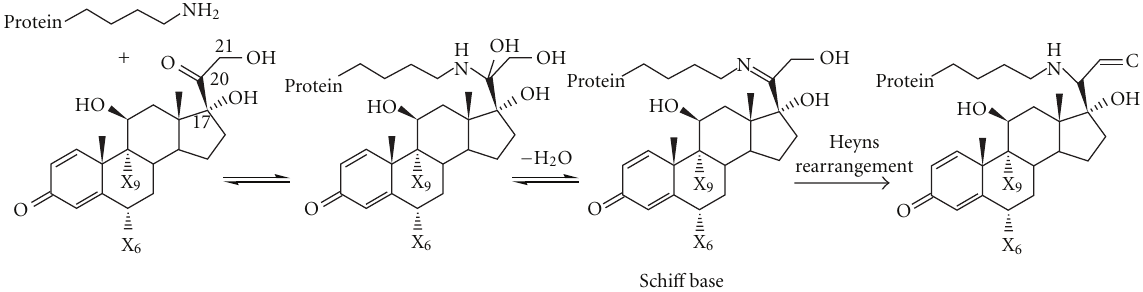
Figure 1: Mechanism of steroid-induced cataract formation adapted from